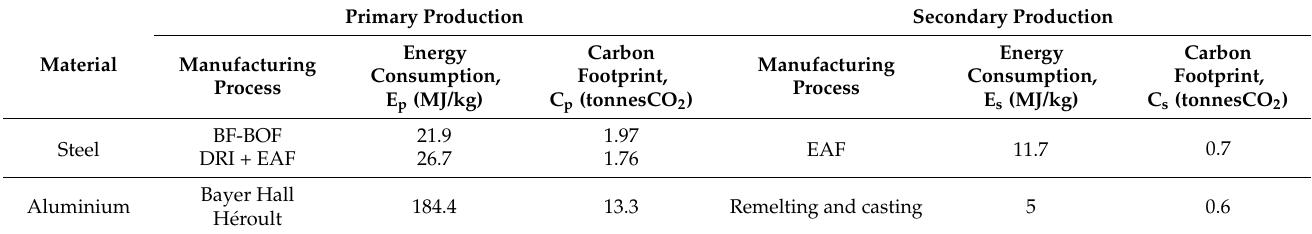
Table 1. Primary and secondary processes’ average specifications for raw material